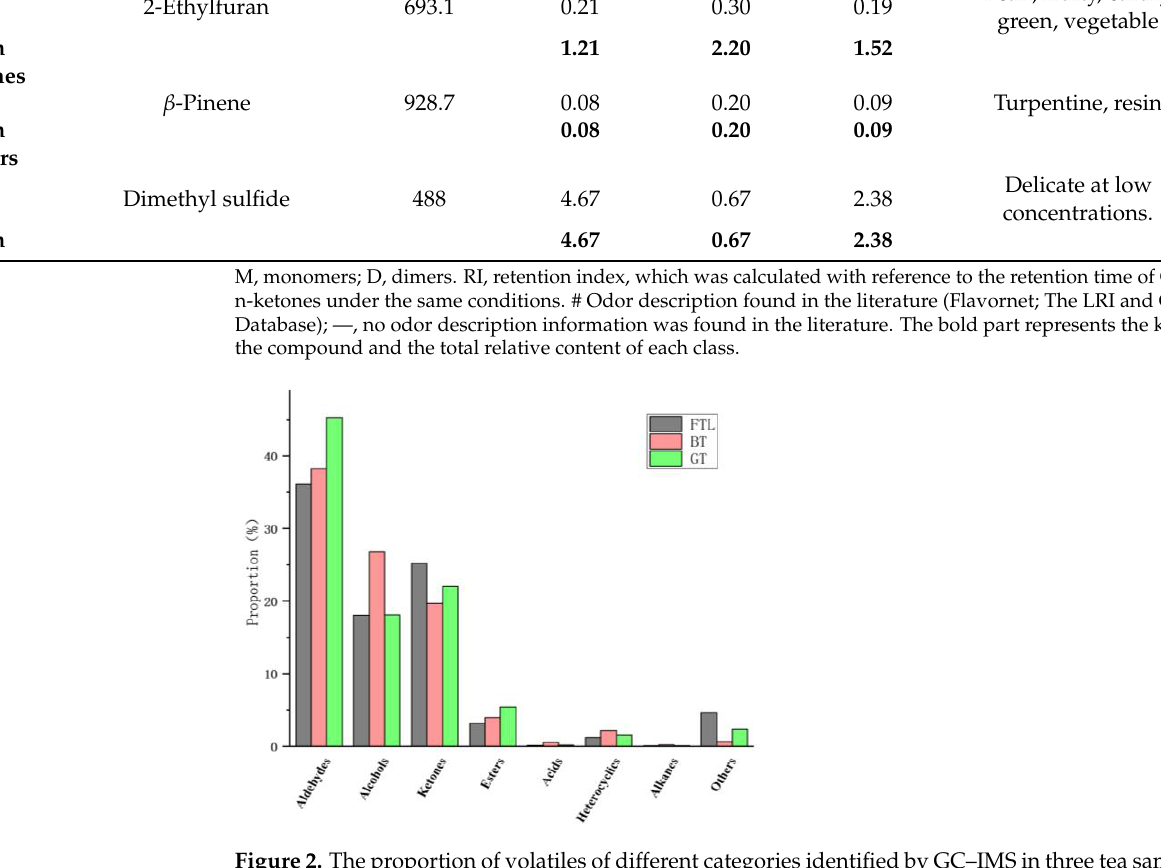
Figure 3. Gallery plot fingerprint of different teas by GC-IMS. The compounds with higher content are framed in the colored boxes: brown for FTL, red for BT, while/purple for GT.